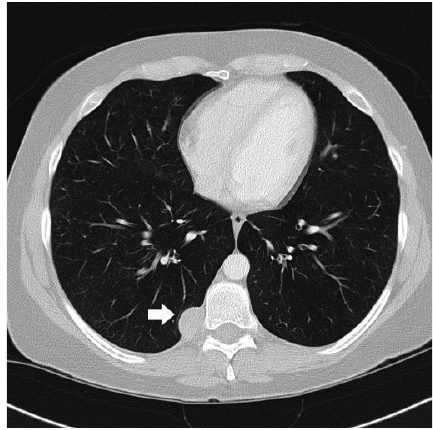
Figure 1: CT scan with contrast demonstrates a 2.0 cm posterior mediastinal mass abutting the right T9 rib and vertebral body